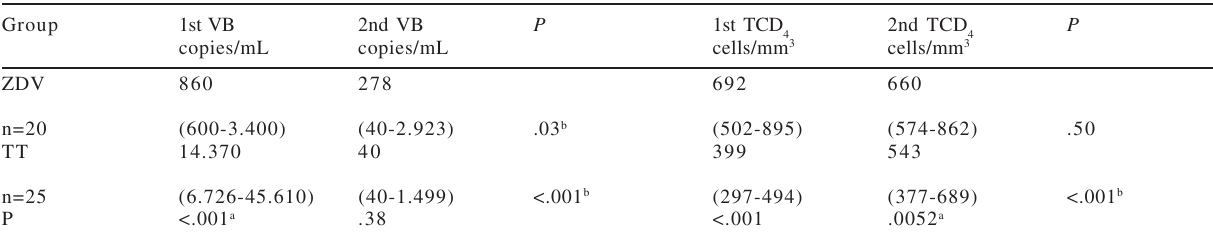
Table 1 - HIV-1 viral burden (VB) and T-CD 4+ lymphocyte counts of HIV-infected pregnant women in two different periods during pregnancy.